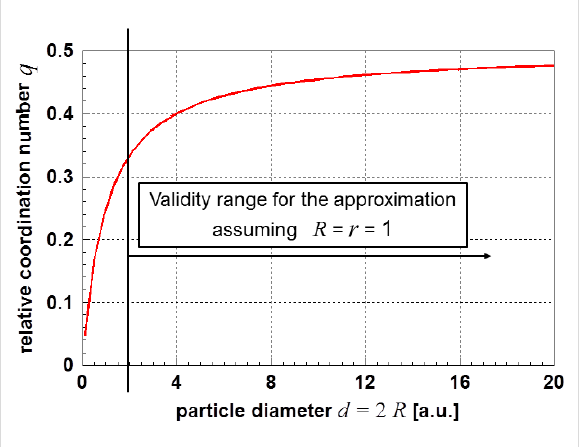
Figure 3: Relative coordination number q of an atom at the surface of a spherical particle as function of the particle diameter d = 2 R using Equation 5.